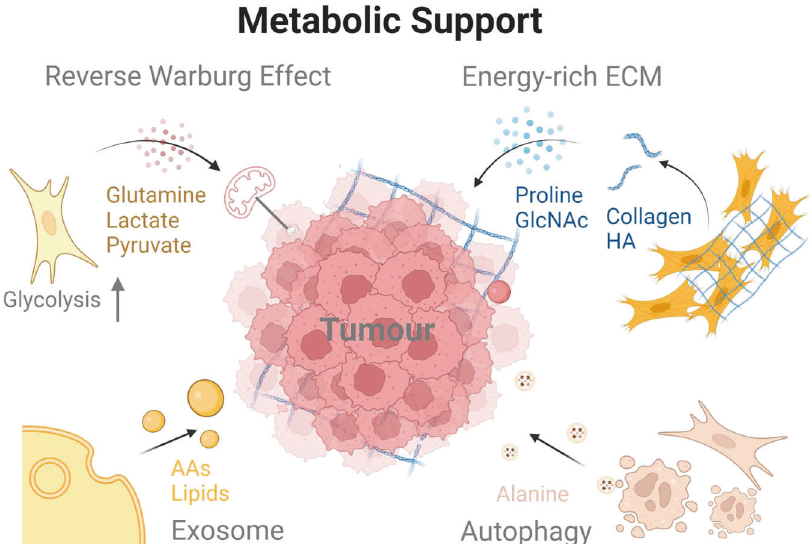
Fig. 3 CAFs support metabolic reprogramming of tumour cells. CAFs help malignant cells overcome nutrient deprivation. Under the in fl uence of tumour cells, CAFs perform aerobic glycolysis and provide nutrients to PDAC cells. Moreover, CAFs-derived collagens and HA in the ECM can also be used by tumour cells. Also, CAFs contribute to the metabolism reprogramming of malignant cells. The exosomes released by CAFs can also fuel the metabolism in PDAC cells. Furthermore, CAFs engage in autophagy to generate energy-rich metabolites that serve as alternative carbon sources for mitochondrial metabolism and tumour